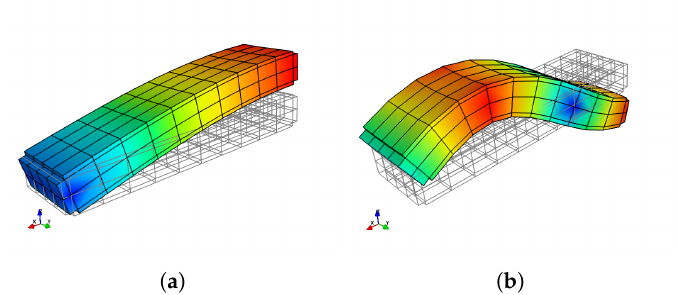
Figure 10. Waveshape of wave 0 of unit cell C: ( a ) at the first propagating zone; ( b ) at the second propagating